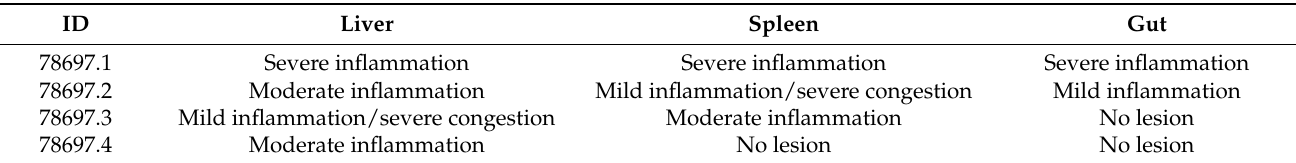
Table 2. Histopathology.